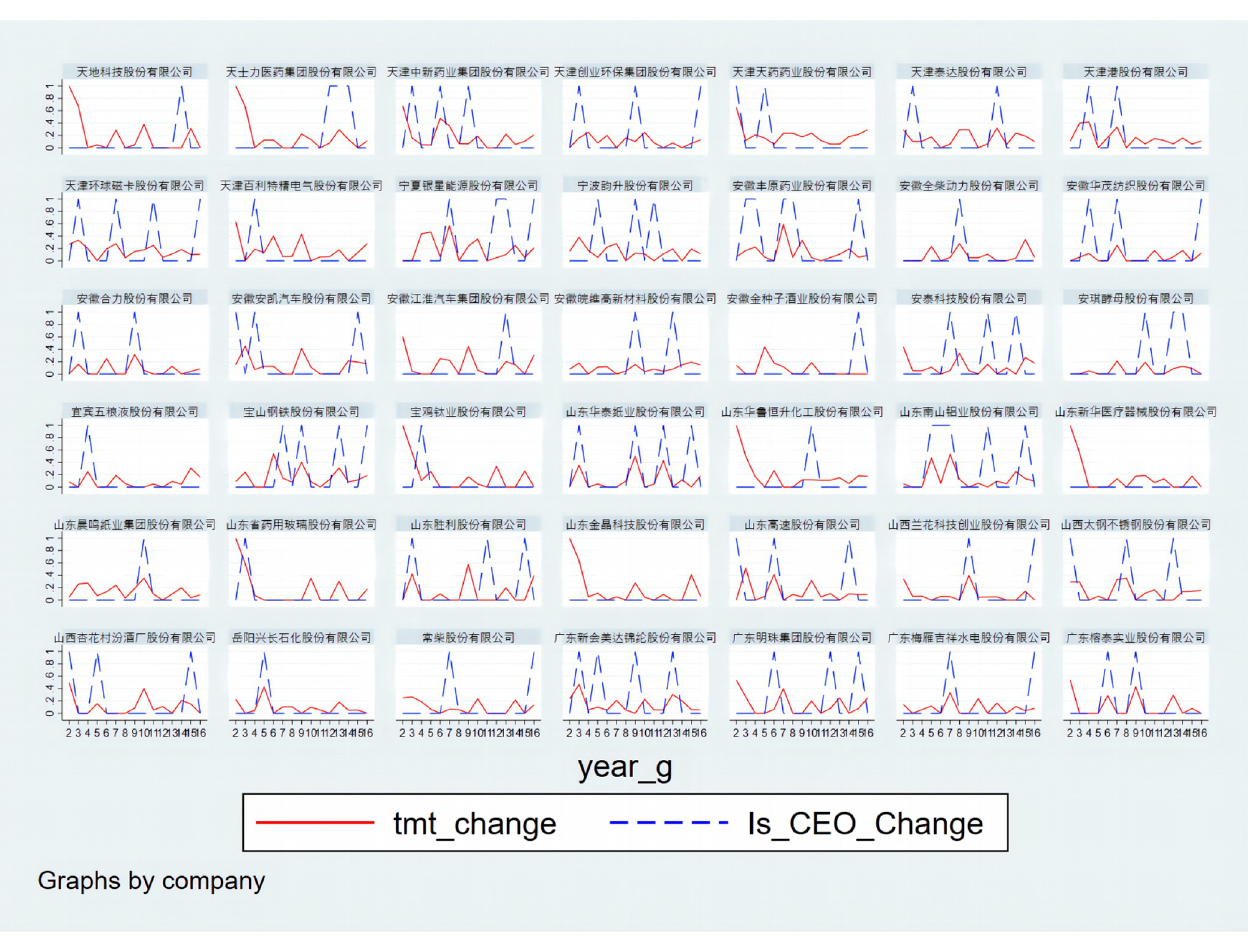
Fig 2. The change rate of the CEO and top management